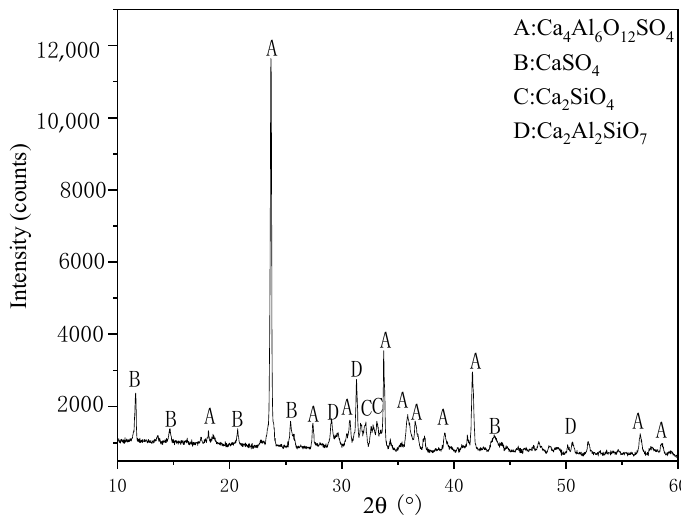
Table 4. Chemical composition of binder materials (wt. %).